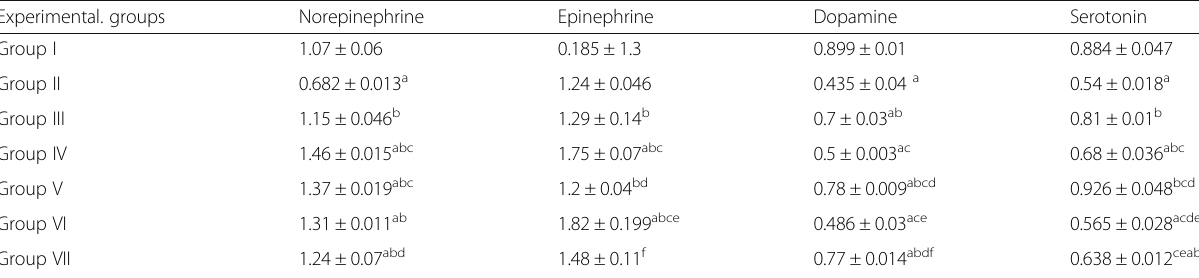
Table 6 The levels of monoamines ( μ g/g) in hypothalamus of male offspring in groups I to VII, 70 days postnatal. Data were presented as a mean of eight rats ± SEM Experimental. groups